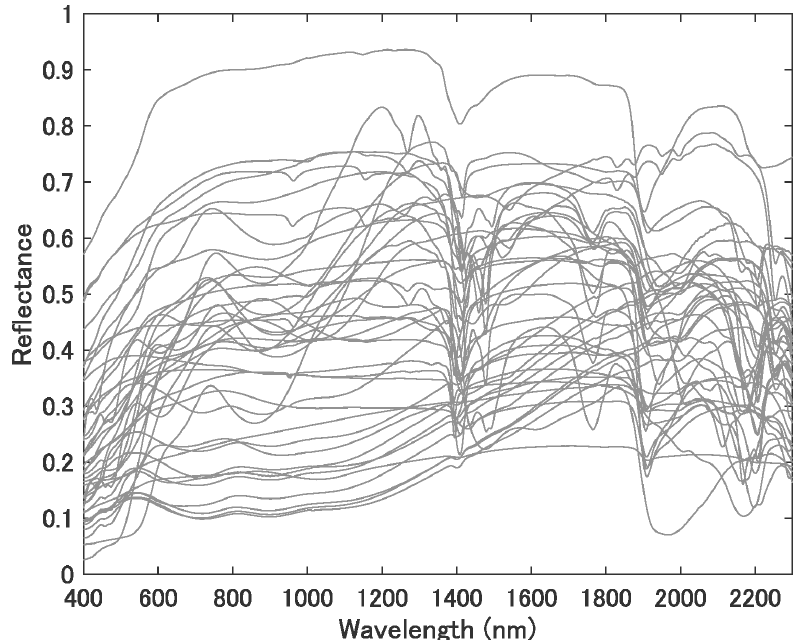
Figure 3. Reflectance samples for soil, rocks, and their mixtures obtained from the USGS spectral library